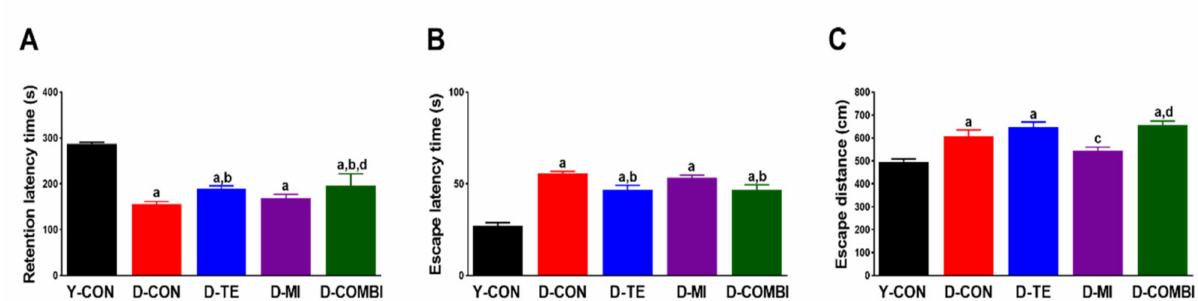
Figure 5. Effect of treadmill exercise and MitoQ on learning and memory tasks in D-gal induced aging rats. ( A ) The working memory test after performing the passive avoidance task 3 days before the end of treadmill exercise (TE). Patterns of ( B ) escape latency time and ( C ) escape distance to cross to the former platform location in the water maze test. Bonferroni post hoc test was used after ANOVA. Values are means ± SEM. a Denotes statistical difference from the Y-CON group. b Denotes statistical difference from the D-CON group. c Denotes statistical difference from the D-TE group. d Denotes statistical difference from the D-MI group ( p <